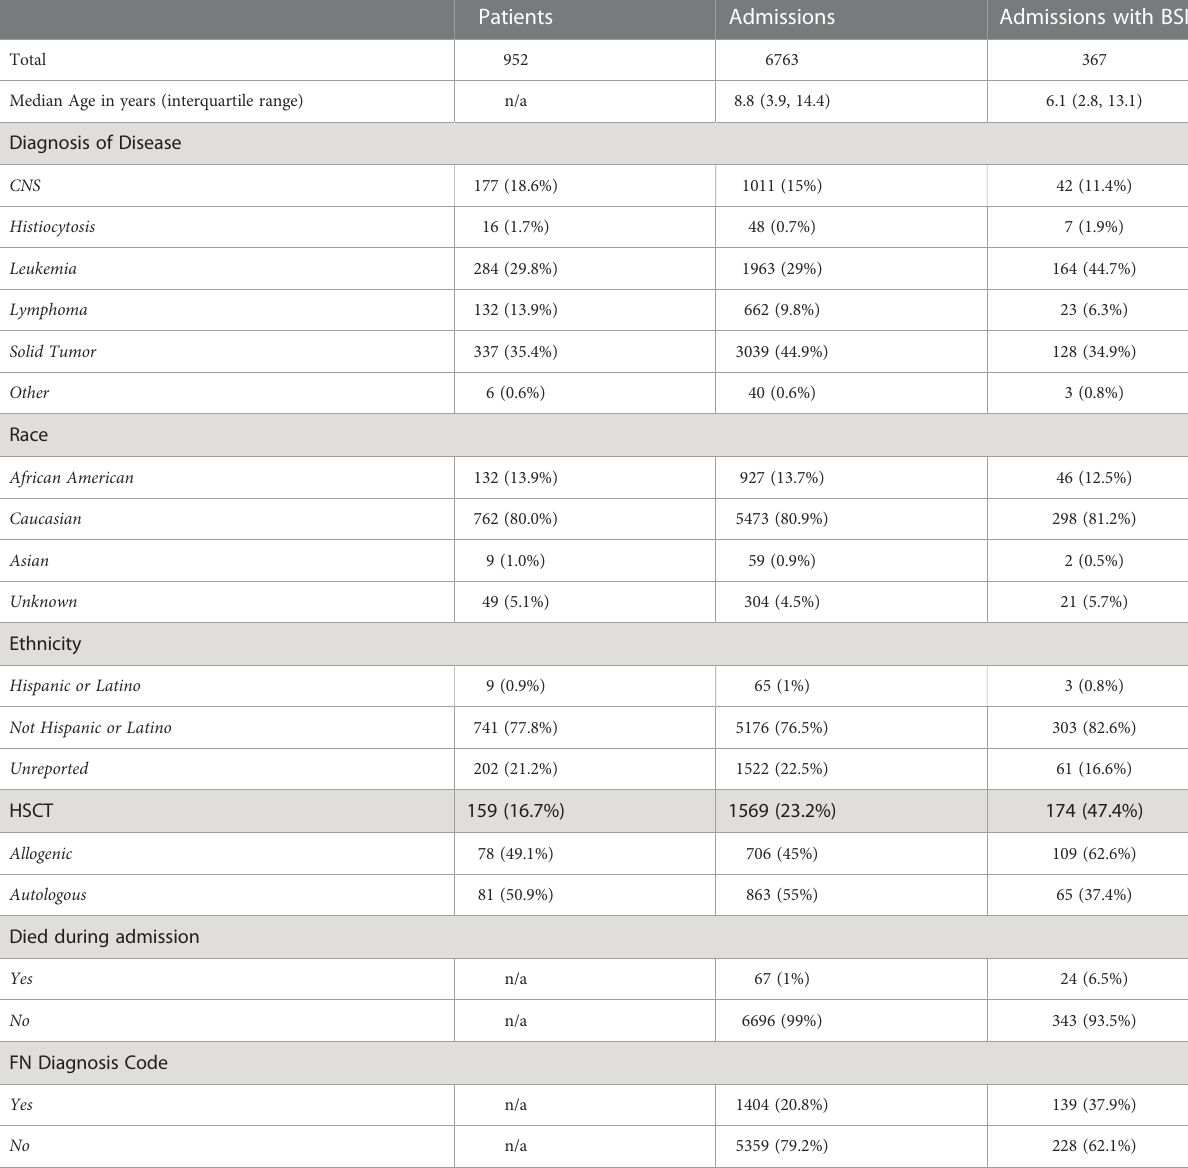
TABLE 1 Characteristics of pediatric oncology patients and admissions during the study